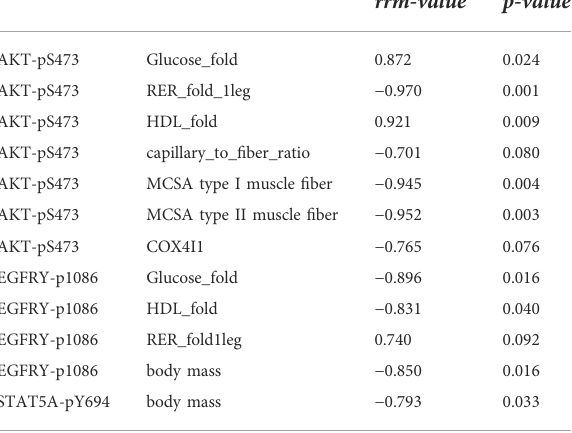
TABLE5Linearrelationshipbetween the phosphorylationofsignaling proteins and parameters of glucose